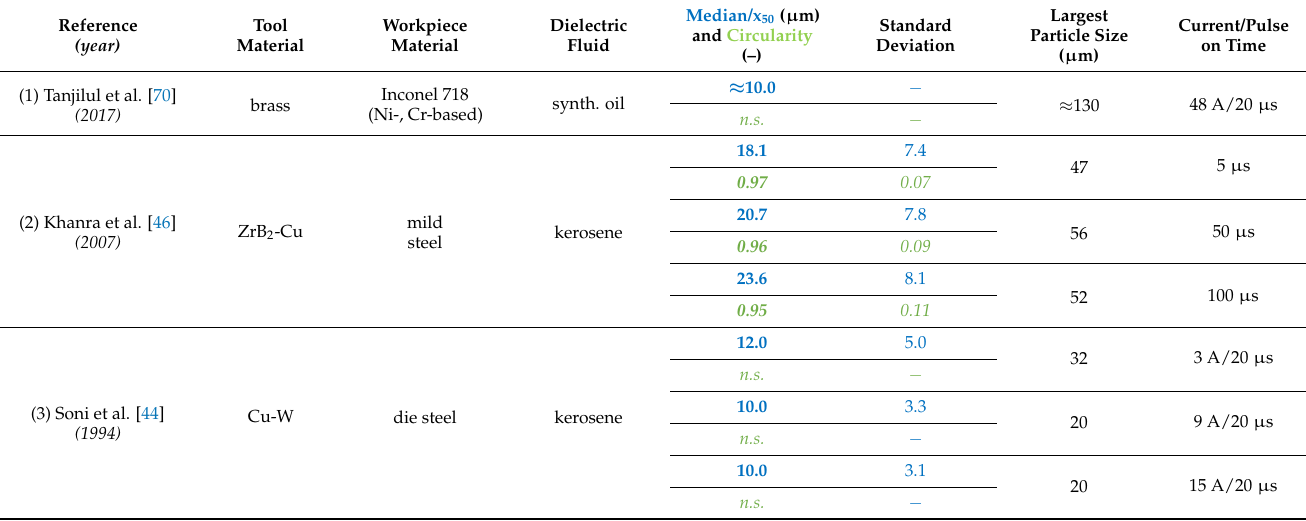
Table 2. Overview of debris particle sizes and form factors as well as used